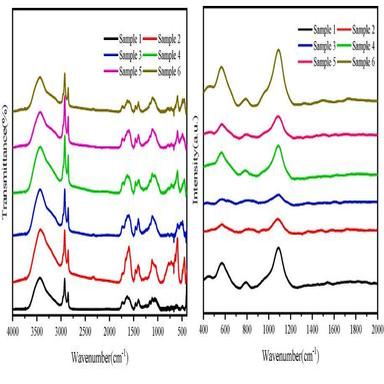
Infrared and Raman spectra of BS and CPCMs.